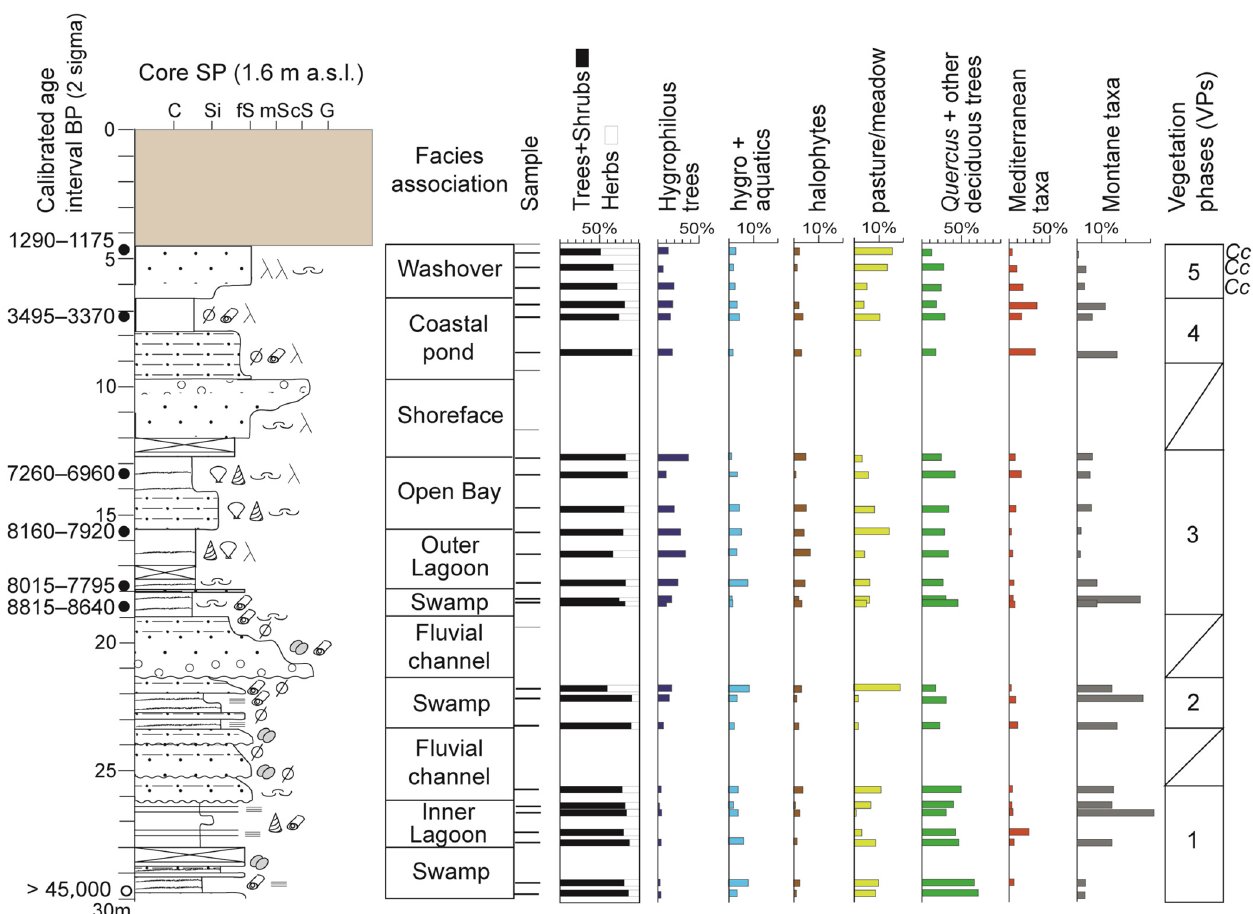
Figure 5. Stratigraphy, facies characterization, and vertical distribution of main pollen groups of core SP. Samples with countable pollen grains are reported as bold lines. The vegetation phases are also shown. Cc indicates the presence of cultivated plants in the pollen record. C: Clay; Si: Silt; fS: Fine sand; mS: Medium sand; cS: Coarse sand; G: Gravel. The uppermost 4 m are composed of anthropogenic materials probably due to harbour construction. See legend in Figure 3 for lithological information.